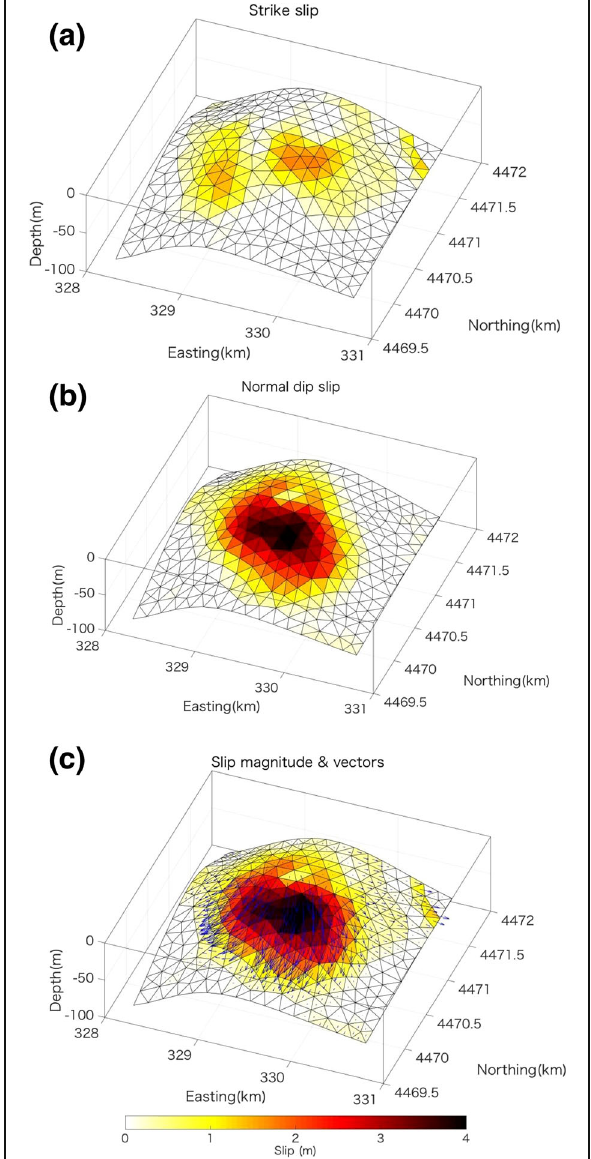
Fig. 13 Slip distributions of a source model inferred from both InSAR and MAI data derived by ALOS-2/PALSAR-2. a Strike-slip component. b Normal slip component. c Slip amplitude and vectors. Note that the scales for vertical axes and horizontal axes are